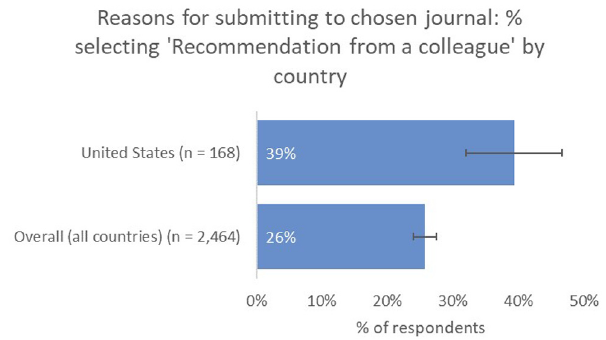
Figure 9. Relative importance of recommendation from a colleague in determining choice of journal for US-based authors.